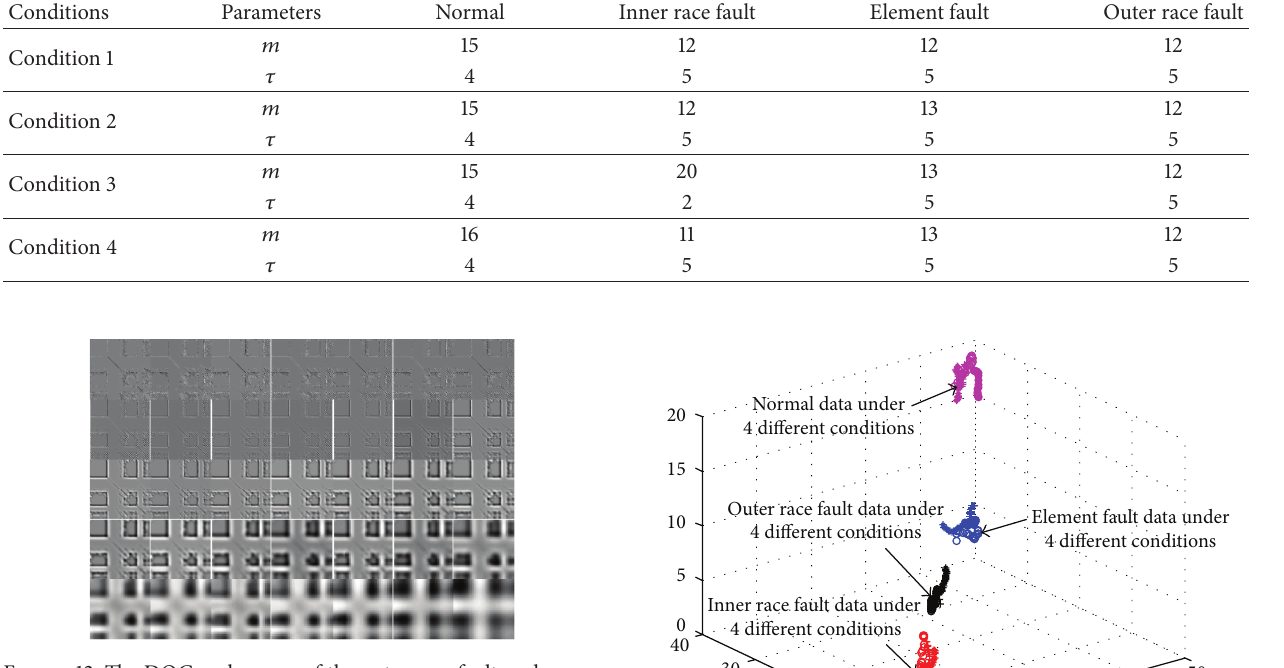
Figure 12: The DOG scale space of the outer race fault under con- dition 1.